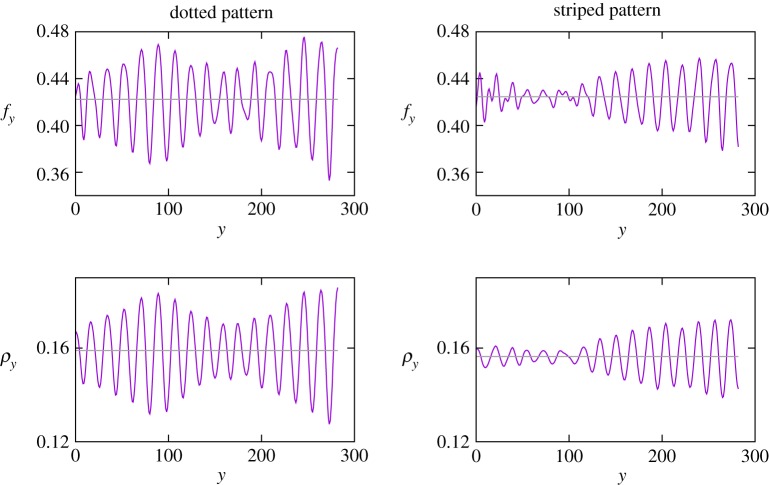
General y. The left column is for the dotted pattern, while right one is for the striped pattern. We can see that fy and ρy, are fluctuating in y, and the dotted pattern has a much larger deviation than the striped pattern. The dotted patterns locally have higher fy than striped patterns.